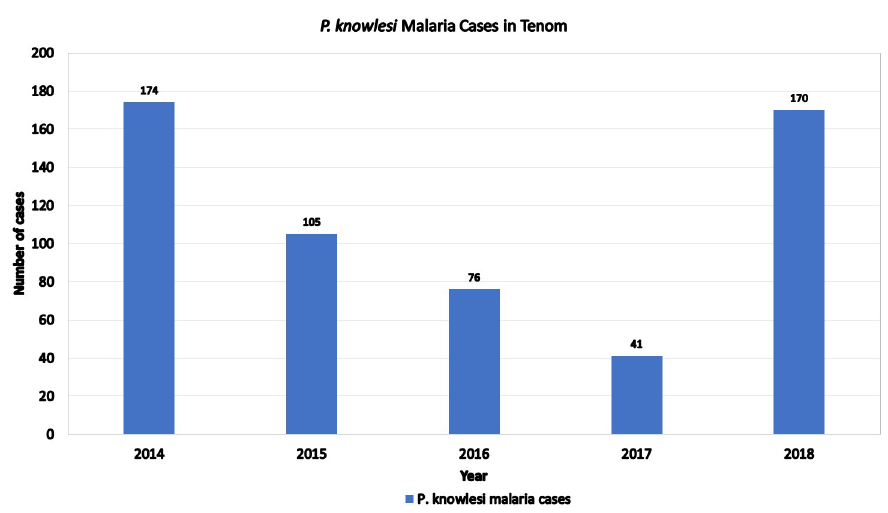
Fig 13. P. knowlesi malaria cases in Tenom,